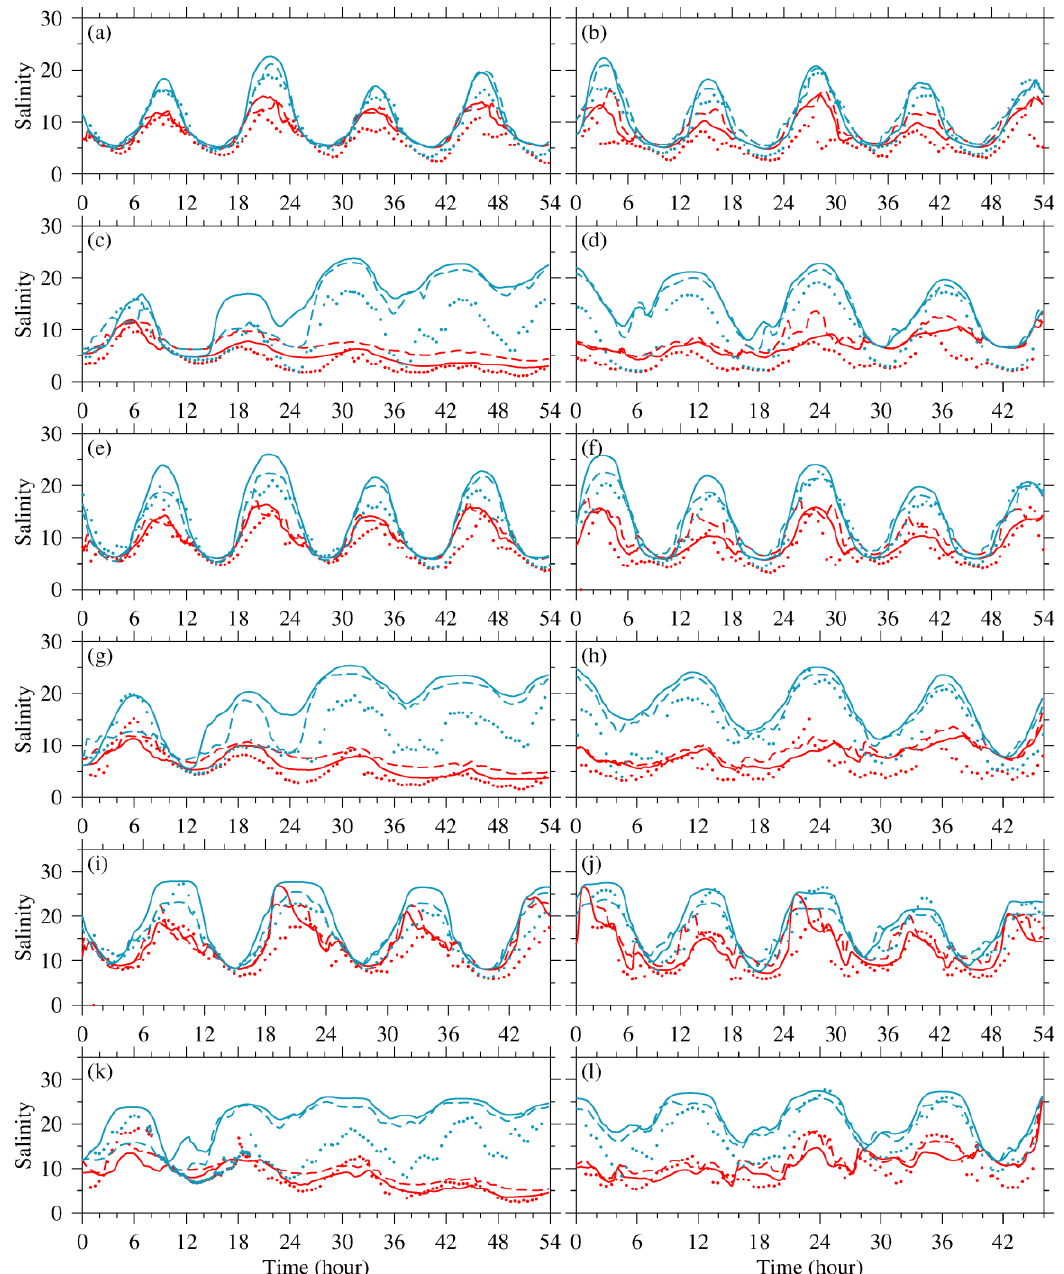
Figure 13. Time series of salinity obtained from the observed data (dots), Exp. 0 (solid lines), and Exp. 5 (dashed lines) at site A ( a – d ), B ( e – h ) and C ( i – l ) during four tidal phases (spring: a, e, i; MTAS: b, f, j; neap: c, g, k; MTAN: d, h, l). Red in-dicates surface and blue indicates bottom.